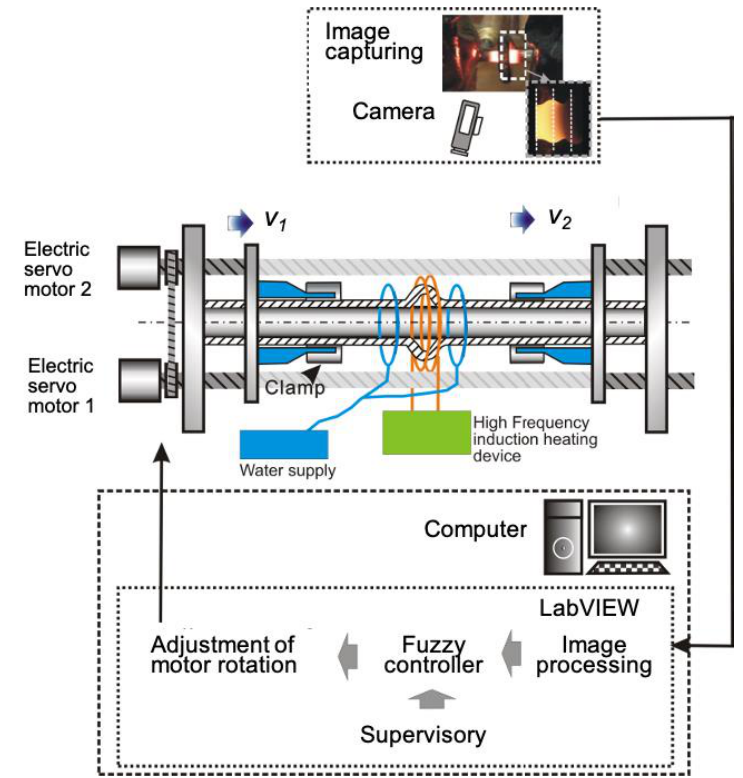
Figure 13. Experimental apparatus for the fuzzy control using a machine vision system.